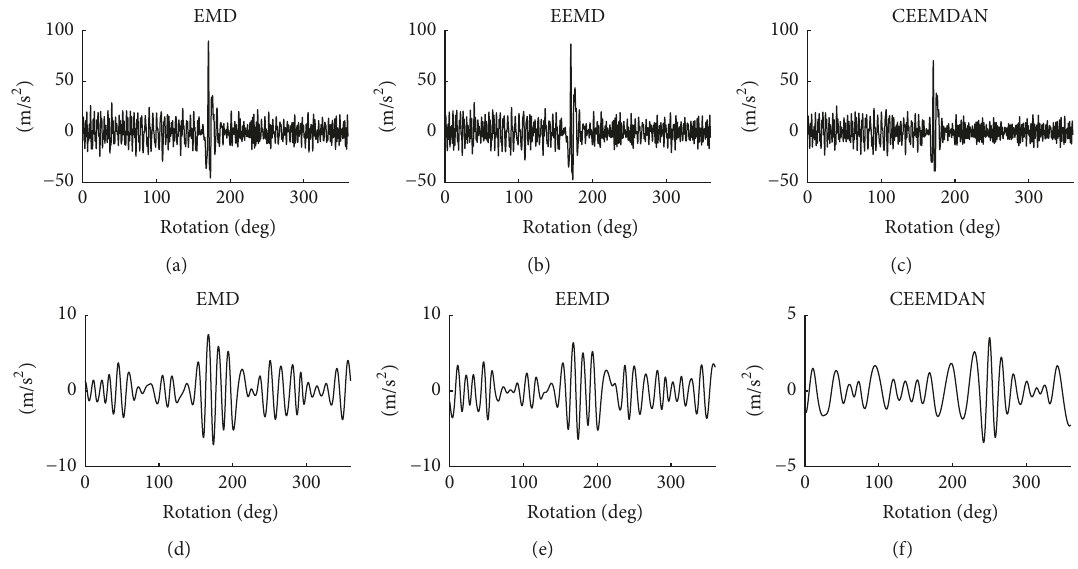
Figure 16: Representative signals of (a–c) gear II and (d–f) gear III for Case